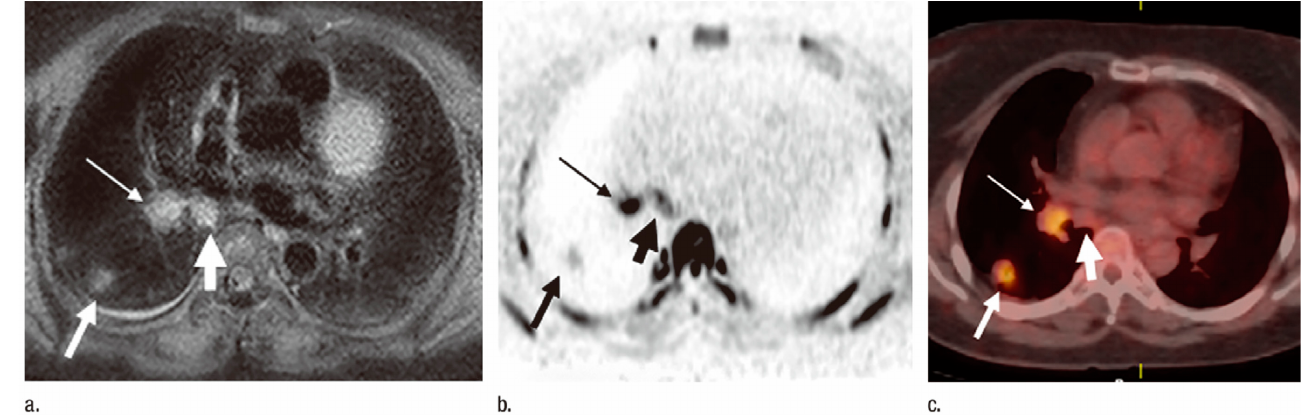
Figure 2. Images of a 73-year-old patient with pathologically diagnosed N2 adenocarcinoma (per- mission obtained from reference #34). ( a ) STIR turbo SE image shows primary lesion (medium-thick arrow), subcarinal lymph node (thick arrow), and right hilar lymph node (thin arrow) with high signal intensity (SI). The primary lesion in the right lower lobe is visible in the same axial plane. LSRs of lymph nodes were 0.75 (right hilar lymph node) and 0.78 (subcarina lymph node), LMRs were 1.7 (right hilar lymph node) and 1.9 (subcarina lymph node), and visual scores were 5. An accurate diagnosis of N2 disease was made. ( b ) DW MR image shows primary lesion (medium-thick arrow), subcarina lymph node (thick arrow), and right hilar lymph node (thin arrow) with high SI. The primary lesion in the right lower lobe is visible in the same axial plane. ADCs of lymph nodes were 2.8 × 10 − 3 s/mm 2 (right hilar lymph node) and 3.4 × 10 − 3 s/mm 2 (subcarina lymph node), and visual scores were 5. An accurate diagnosis of N2 disease was made. ( c ) FDG PET/CT image shows primary lesion (medium arrow) and right hilar lymph node (thin arrow) with high uptake of FDG and subcarina lymph node (thick arrow) with low uptake of FDG. Primary lesion in the right lower lobe is visible in the same axial plane. SUV max of lymph nodes was 3.2 (right hilar lymph node) and 1.5 (subcarina lymph node), and visual scores were 5 (right hilar lymph node) and 2 (subcarina lymph node). An inaccurate diagnosis of N1 was